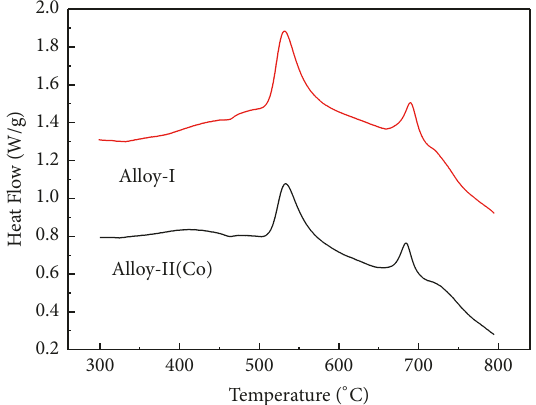
Figure 3: DSC curves of as-quenched alloy